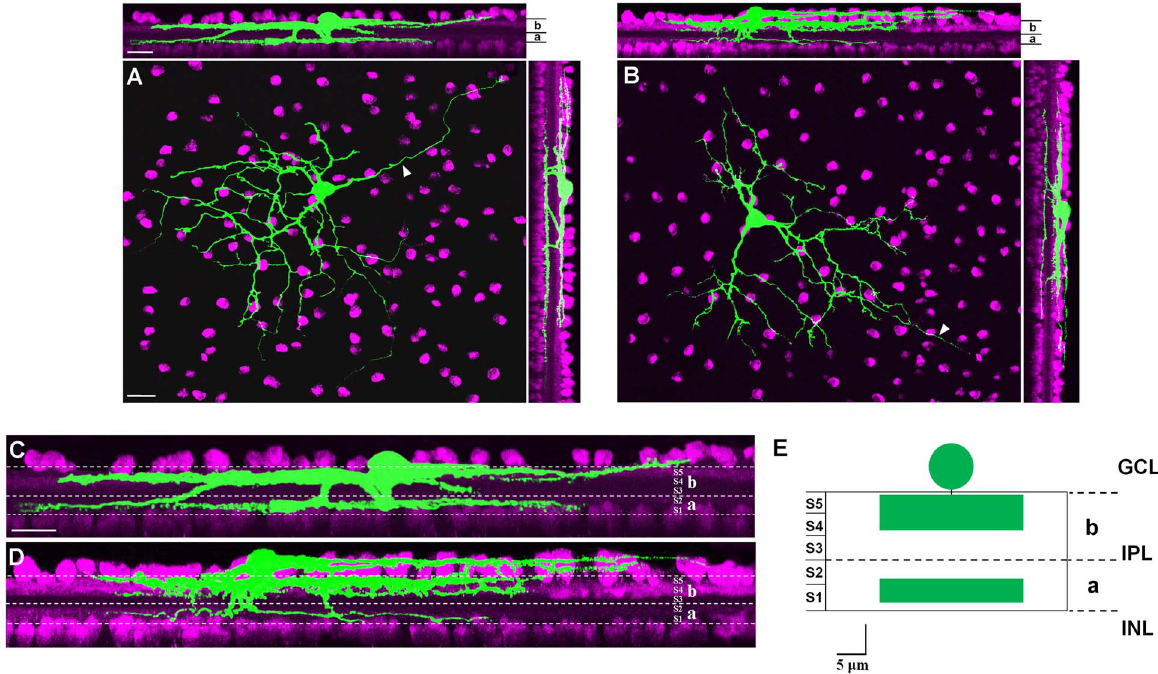
Figure 6. Dendritic stratification of caudal periaqueductal gray (cPAG)-projecting retinal ganglion cells (RGCs). (A–B) These two cells are distinctly bistratified in sublamina a and b of the inner plexiform layer (IPL). Cholinergic amacrine cells were labeled with color magenta. (C–D) High-power images of upper planes in (A) and (B), illustrating that these two cPAG-projecting RGCs could distinctly bistratified in IPL. White dotted lines indicated borders of sublamina a and b of IPL. (E) Schematic summary of ramification pattern of cPAG-projecting RGCs. INL: inner nuclei layer; IPL: inner plexiform layer; GCL: retinal ganglion cell layer; a: sublamina a of inner plexiform layer; b: sublamina b of inner plexiform layer; S1–S5: stratum 1–5. Scale bars: 20 m m in A (applies to B); 20 m m in upper panel of A (applies to upper panel of B); 20 m m in C (applies to D); 5 m m in E.